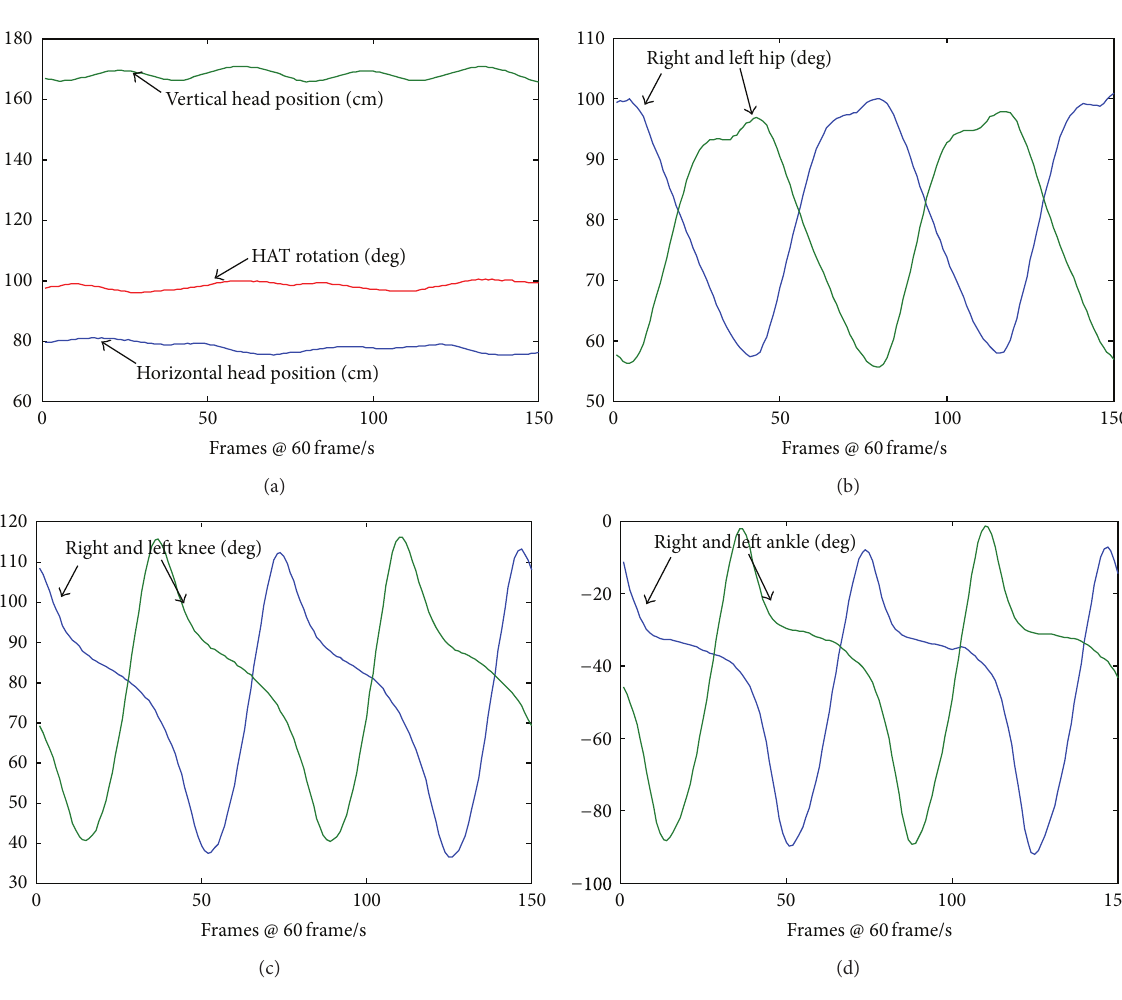
Figure 9: Trajectories used as input to the humanoid model.